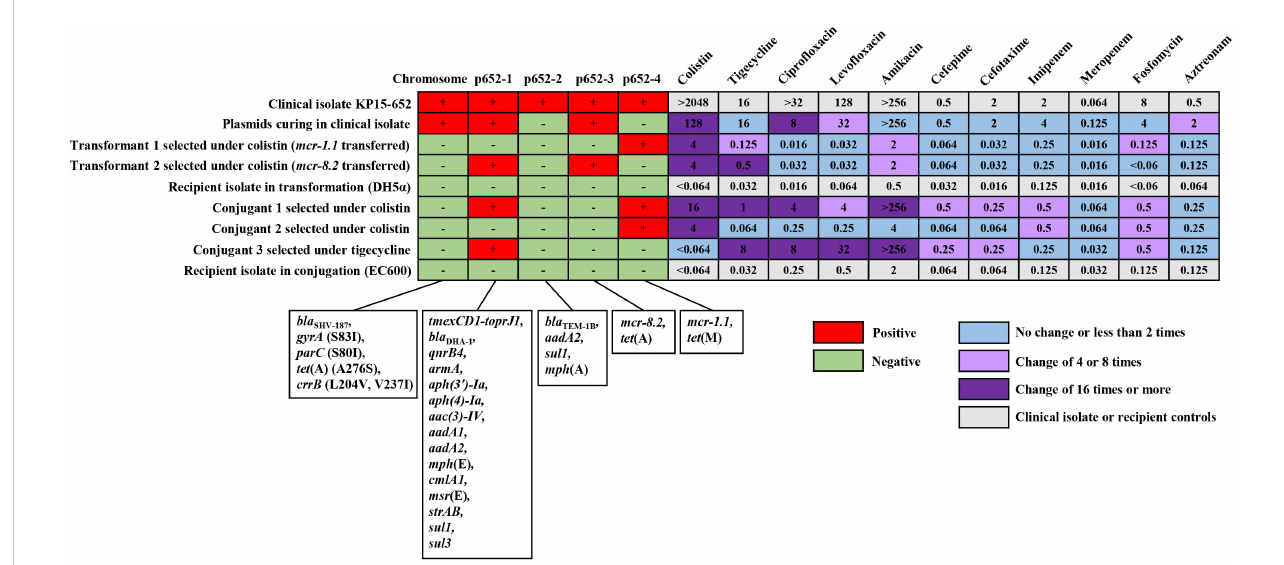
FIGURE 1 The distribution of resistance determinants on chromosome or plasmids and corresponding MIC manners in clinical isolate, plasmid curing isolate, transformants, conjugants and their recipient controls. For the distribution of resistance determinants, the red cell represents the original chromosome or any positive plasmid, and the green cell represents none. For MICs of the antimicrobial agents, the fold change between any acquired clone in the transferability assay and its relative control is illustrated with blue cells for no change or less than 2 times, light purple cells for change of 4 or 8 times and dark purple cells for change of 16 times or more. The light gray cell indicates MICs of the clinical isolate or recipient